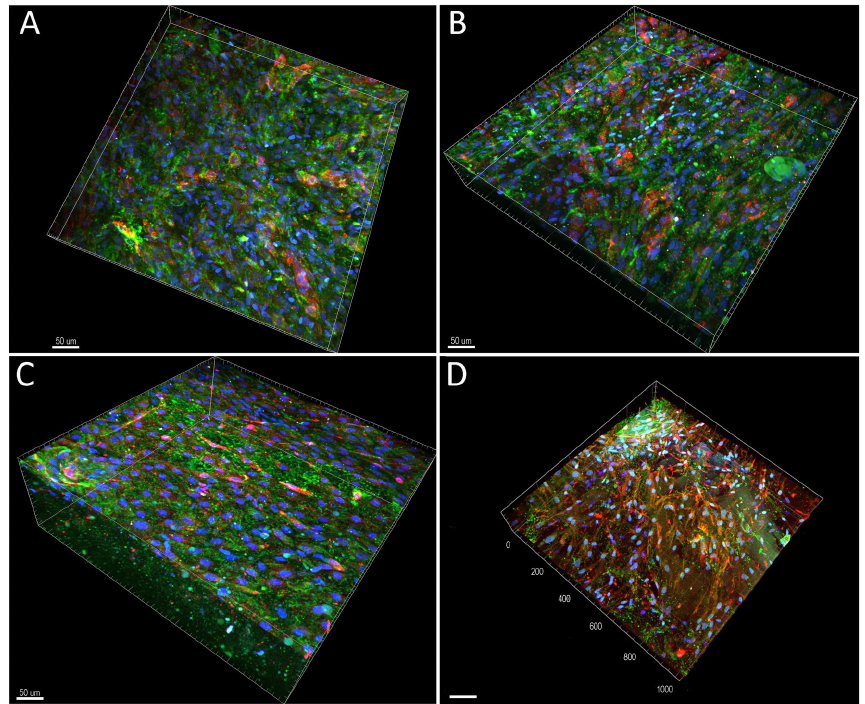
Figure 10. Immunofluorescence staining of von Willebrand factor in ECs (green) and alpha-actin (red) in ASCs in collagen gel reinforced with collagen particles cultured in DMEM with 2% of FS ( A ), with added PVA nanomats ( B ), with PVA_PL nanomats ( C ) or in medium with TGF- β 1 + BMP- 4 ( D ) for 8 days and, subsequently, in EGM-2 medium, for 6 days. The cell nuclei are counterstained with Hoechst, Bruker Ultima, obj. × 25, scale bar = 50 µm.